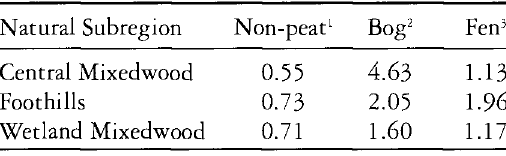
Table 2. Habitat selection indices (used/available) for caribou in northern Alberta from 1993 to 1998.